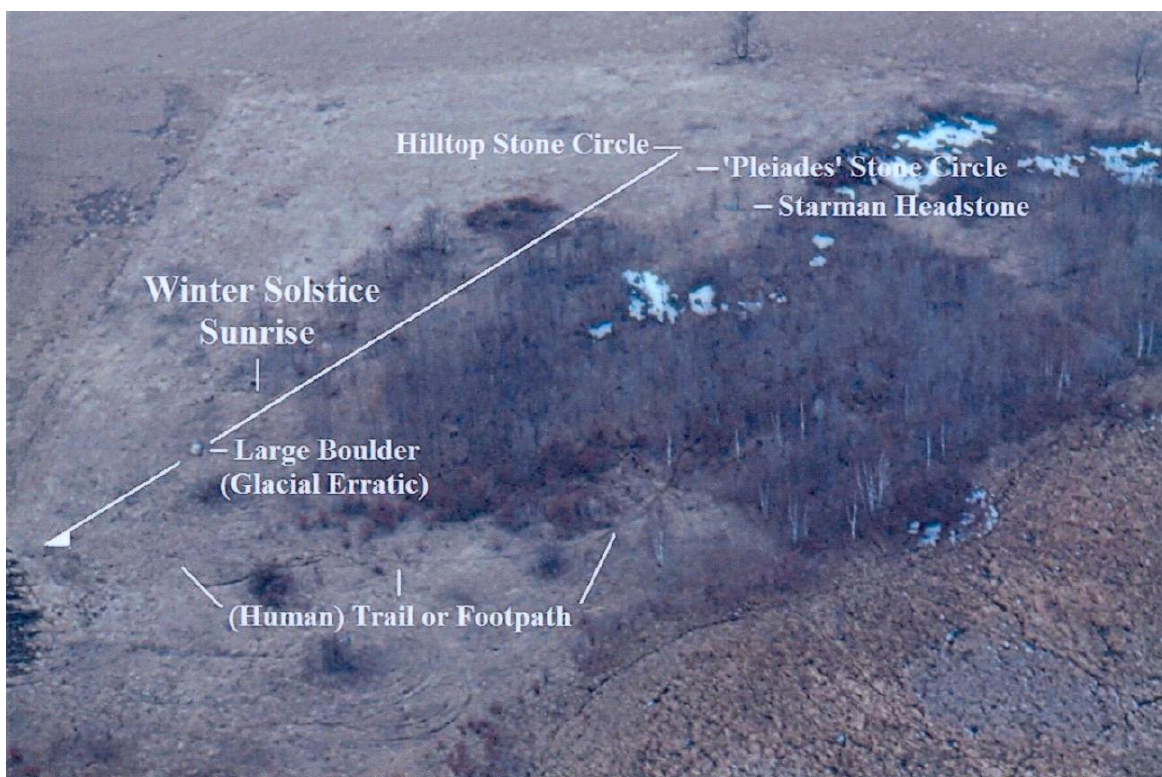
Figure 13. Aerial photo showing the winter solstice sunrise alignment overlooking the large erratic on the south end of the hill. The hilltop and Pleiades circles and Starman headstone locations are also